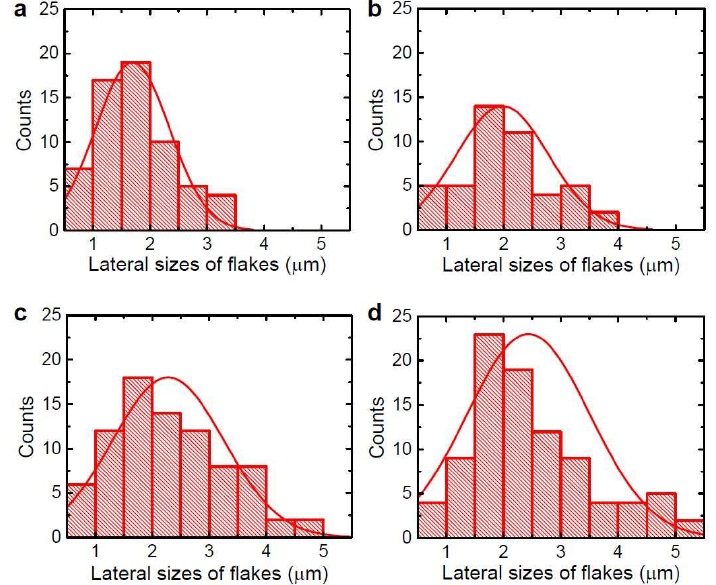
Figure 3. Lateral-size distributions of rGO flakes after sonication treatments for ( a ) 6, ( b ) 10, ( c ) 14, and ( d ) 20 h. The solid lines represent Gaussian fits to the data.